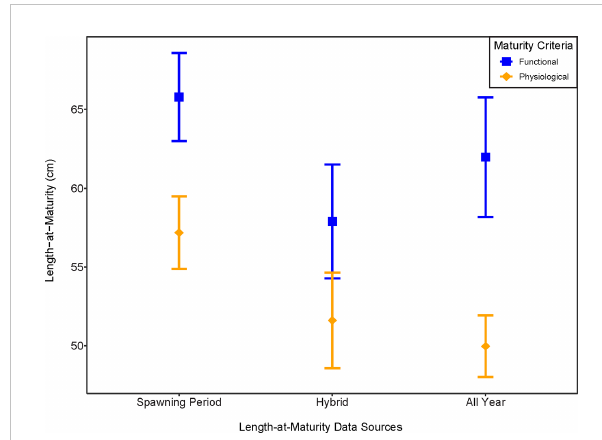
FIGURE 6 A comparison of length-at-maturity L 50 parameters for each of the six maturity classi fi cation criteria analyzed. Spawning period was de fi ned by the presence of spawning capable females (September to December). Hybrid was de fi ned as the Spawning period but with the addition of regenerating females. All Year is de fi ned as including all individuals from all months of the year caught. The error bars indicate 95% con fi dence intervals around the median length at maturity.